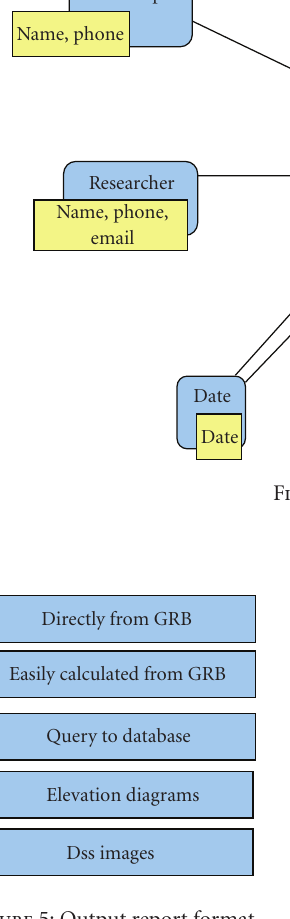
Figure 5: Output report